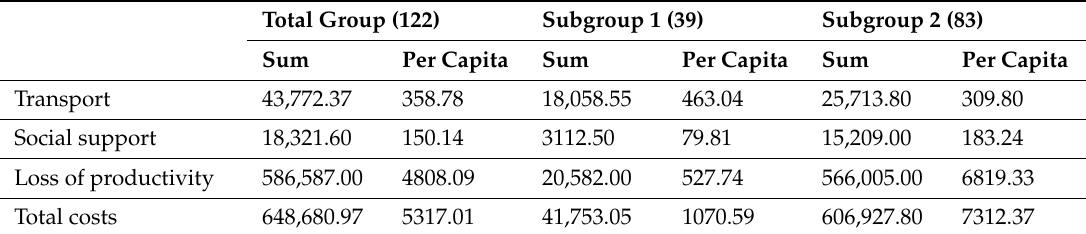
Table 4. Distribution of our real indirect costs / patient / year (EUR).